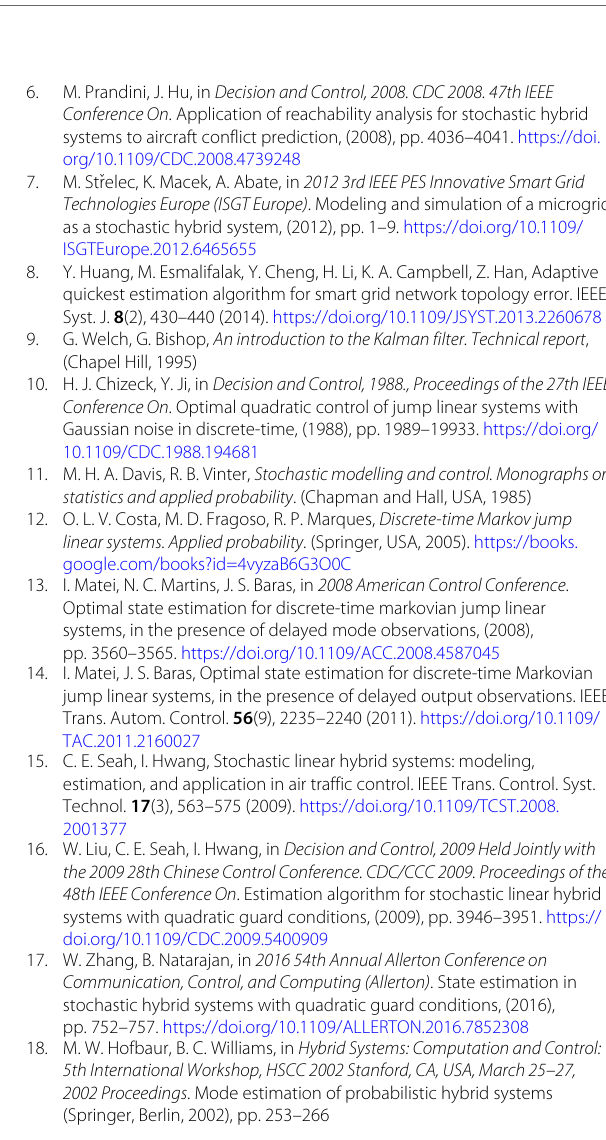
Fig. 7 Monte-Carlo simulation for the smart grid system with λ in stable region and unstable